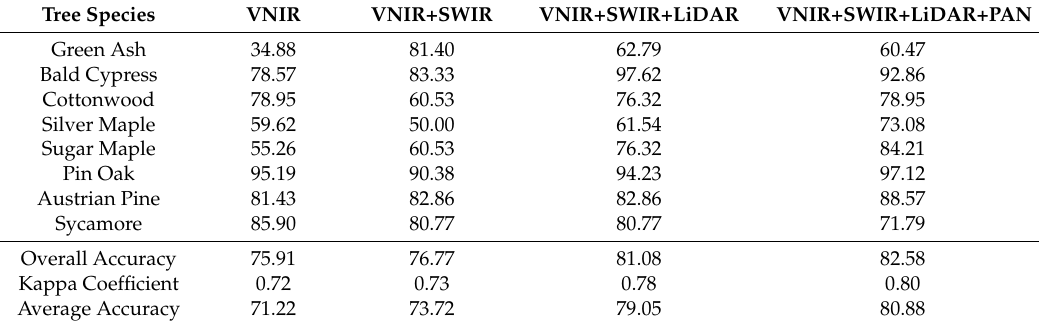
Table 5. Classification accuracies for eight dominant tree species using fused datasets and DenseNet classification using 30% training and 70% testing of each species total reference samples. All values, except for kappa coefficient, are